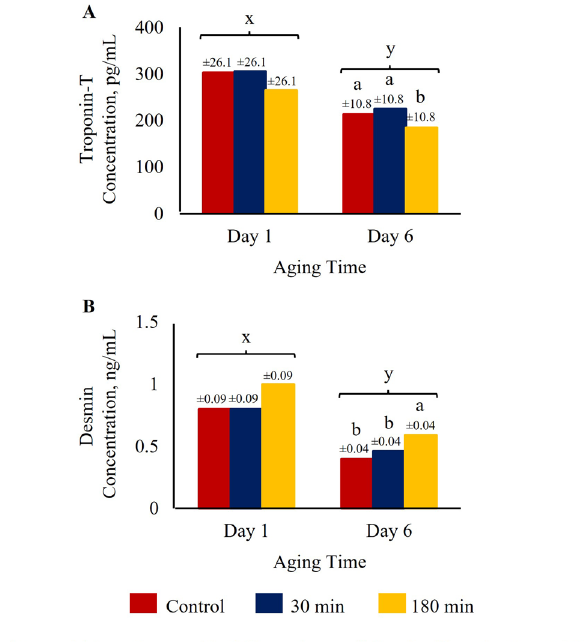
Figure 4. Effects of stress treatment (Control = not transported but held in pens; 30 min = transported for 30 min; 180 min = transported for 180 min) on mean ± SEM loin/rib ( Longissimus dorsi ) chop ( A ) troponin-T and ( B ) desmin concentrations determined at day 1 and day 6 of aging in goats.